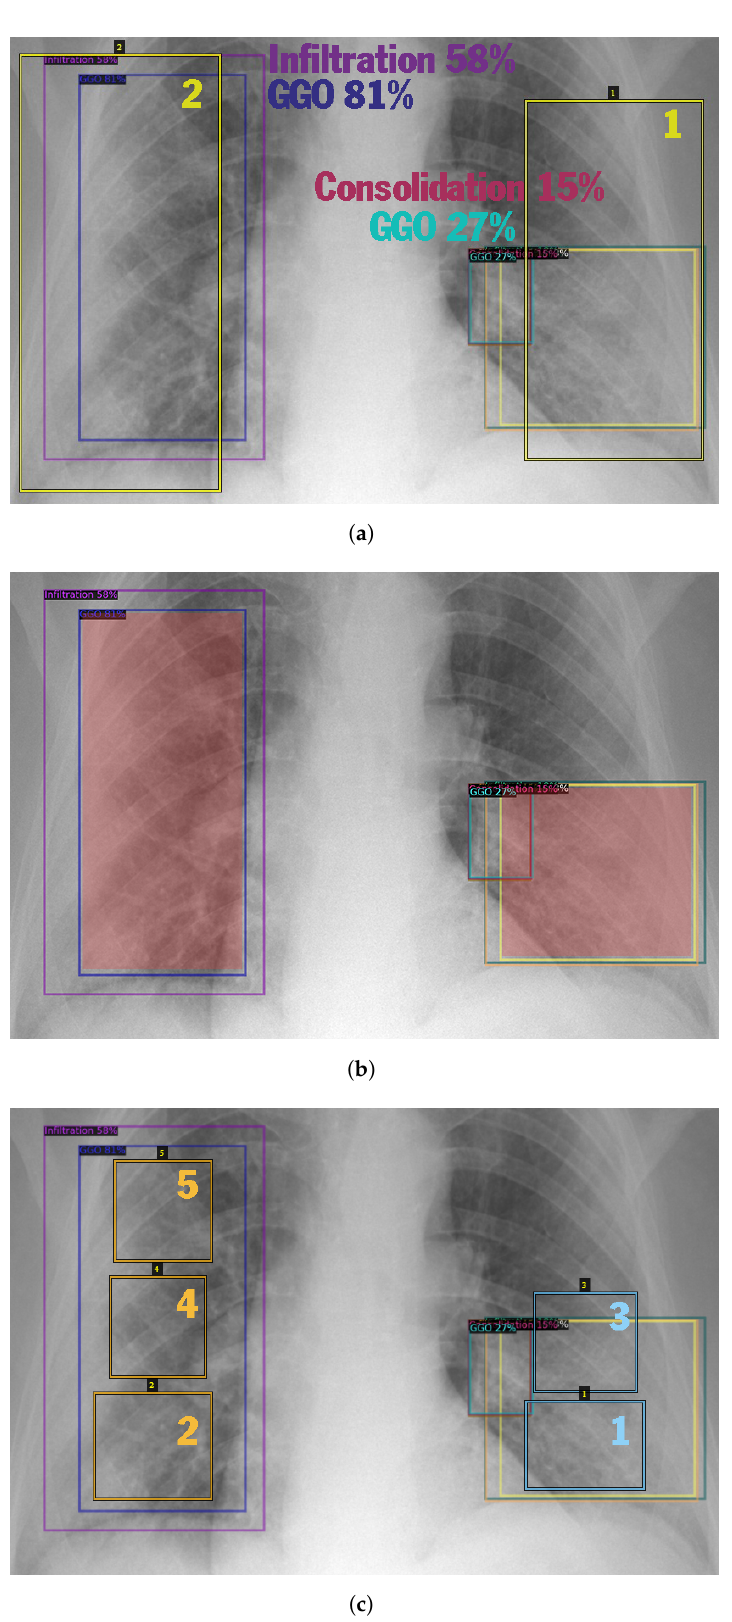
Figure 4. Annotating lung lesion on COVID-19 CXR (SIIM dataset) by our semi-self-supervised method. ( a ) Pseudo boxes and Heuristic boxes. ( b ) Overlapping areas as red zones. ( c ) Final annotated